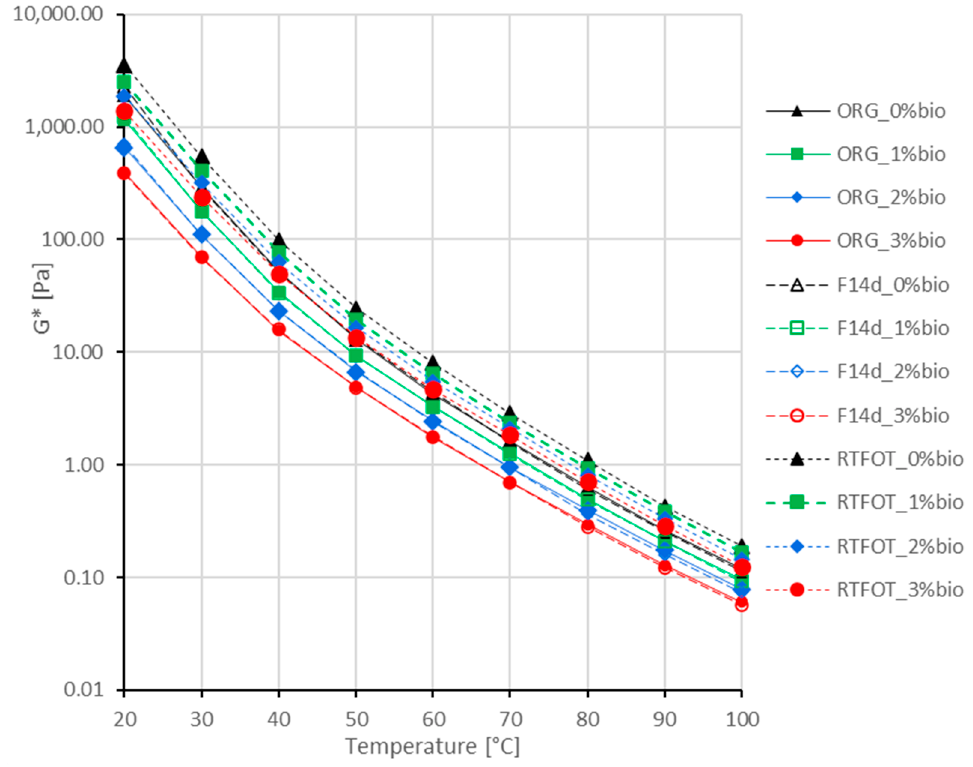
Figure 2. Complex modulus G* of the 45/80–55 polymer-modified bitumen.